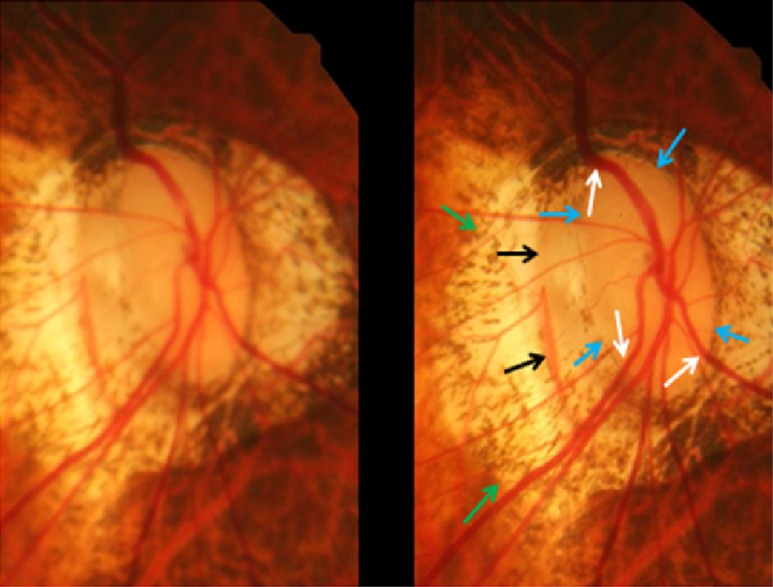
Stereoscopic photograph of a glaucomatous optic nerve head in a highly myopic eye with parapapillary gamma zone (green arrows), parapapillary delta zone (black arrows), and retinal vessel kinking close to the optic disc border (white arrows); blue arrows: optic disc border (peripapillary ring).